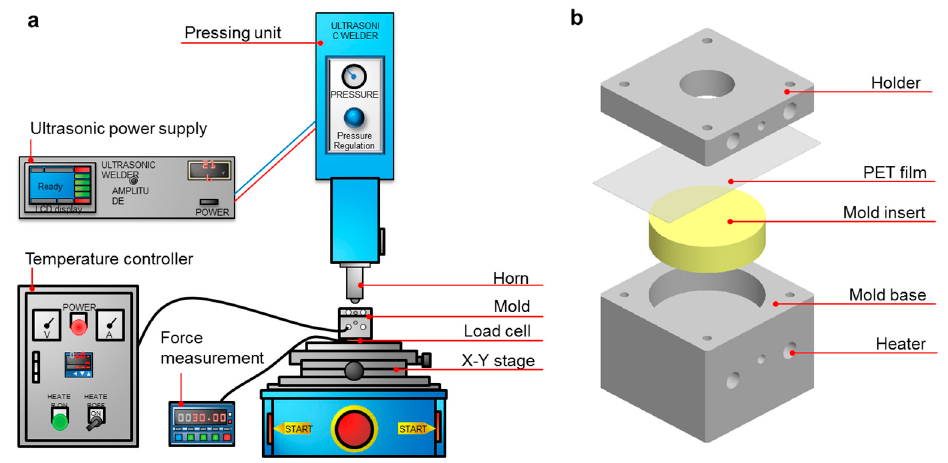
Figure 1. Experimental setup: ( a ) configuration of ultrasonic forming system; ( b ) mold structure for the ultrasonic forming.